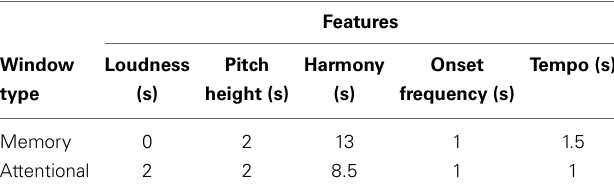
Table 3 | Optimal memory and attentional window durations for each